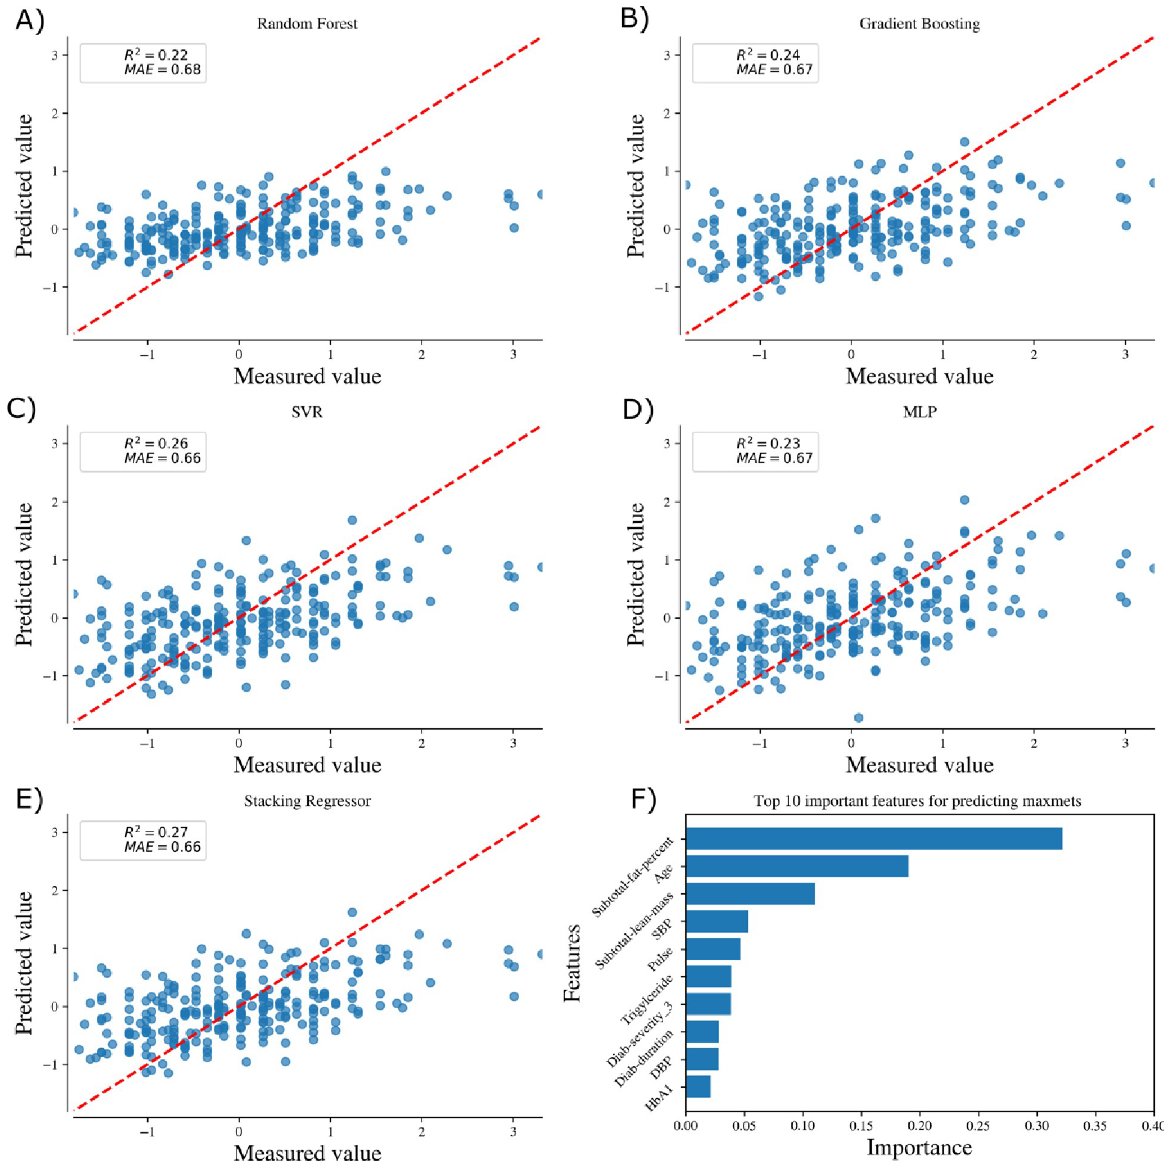
Fig 3. Comparison of 5 machine learning algorithms and top 10 important features for predicting the maximum exercise capability of females (A-F).